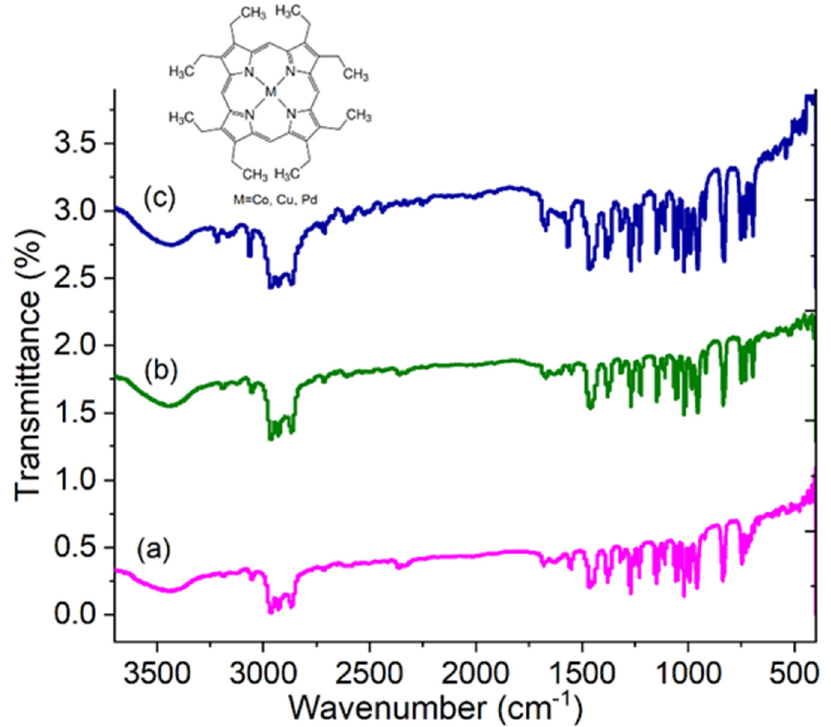
Figure 2. FTIR spectra of ( a ) CoP, ( b ) CuP, and ( c ) PdP in KBr pellets.